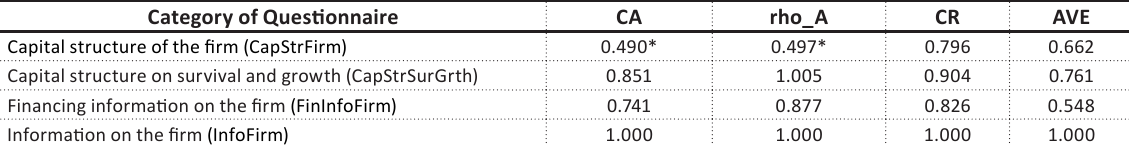
Table 1. Construct reliability and validity